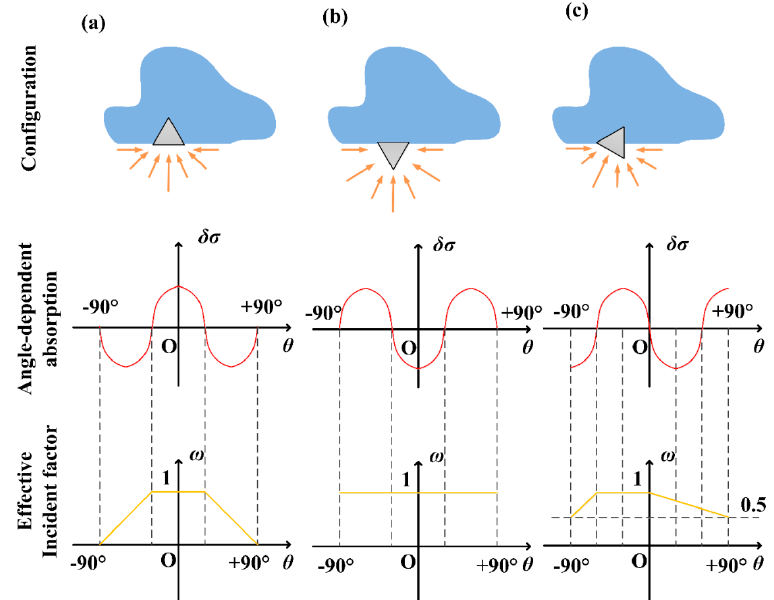
Figure 9. Three typical configurations for the triangular shape at the surface of a yarn are shown, with ( a ) planar, ( b ) tip, and ( c ) half-tip, respectively. The blue part in each configuration stands for the body of a yarn.